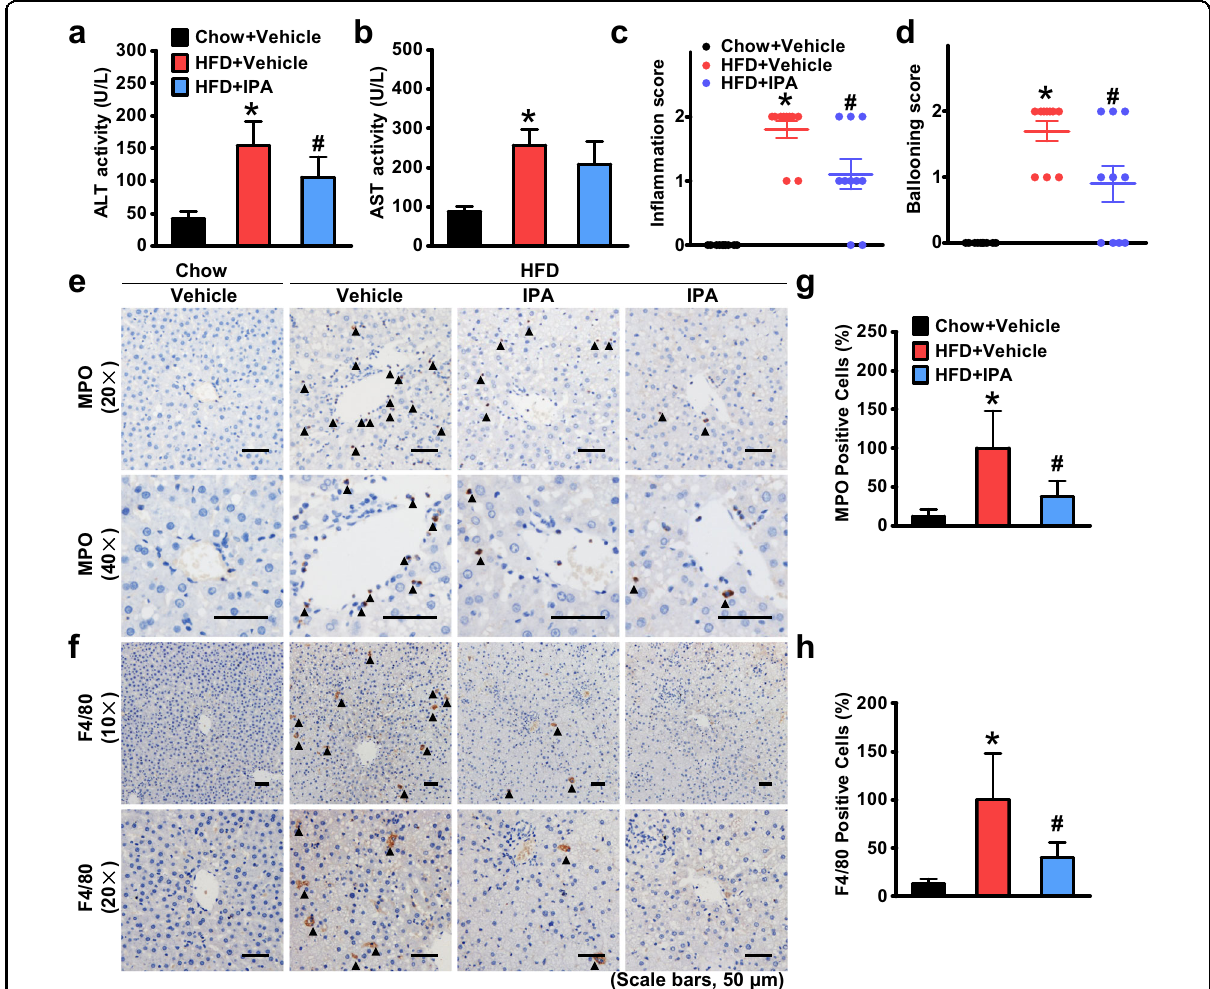
Fig. 4 IPA mitigates hepatic in fl ammation and liver injury in rats fed a high-fat diet. Plasma levels of ALT ( a ) and AST ( b ) were measured. In fl ammation ( c ) and hepatocellular ballooning ( d ) were scored based on histological alterations. Representative immunostaining of myeloperoxidase (MPO) ( e ) and F4/80 ( f ) to show in fi ltration of neutrophils and macrophages, respectively. Arrows denote positively stained cells. Quanti fi cation of MPO- ( g ) and F4/80-positive ( h ) cells expressed as a percentage of those in the HFD + vehicle group. The average numbers of positive cells were quanti fi ed from a randomly selected pool of fi ve fi elds under each condition. The data are presented as the mean ± SEM. n = 8 – 10, * P < 0.05, vs. rats fed a chow diet; # P < 0.05, vs. rats fed a high-fat